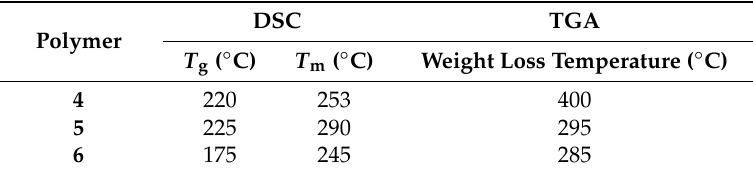
Table 4. T g , T m , and weight loss temperatures of polymers 4–6 .